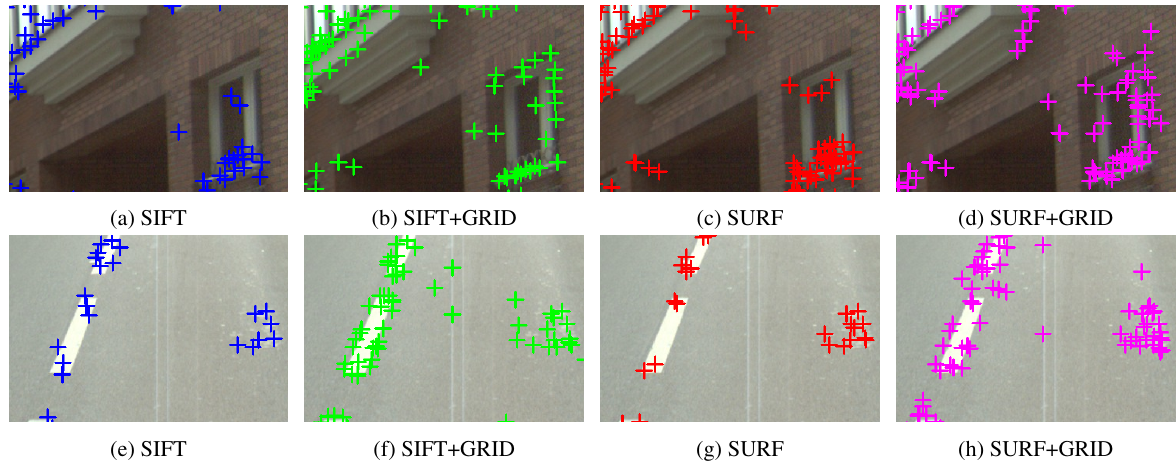
Figure 3. Some interest points are removed on road and facade for SIFT and SURF detectors. But the grid based SIFT or SURF detectors are able to keep these useful points for